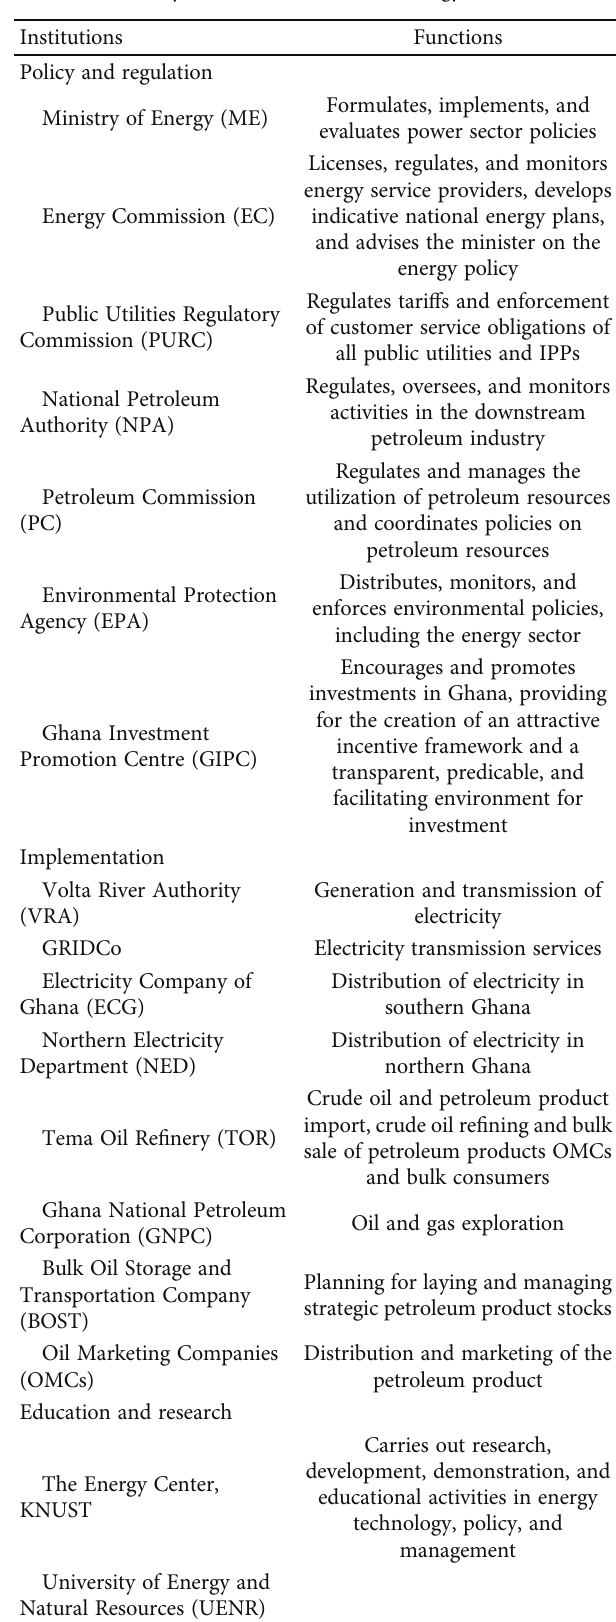
Table 1: Key institutions in Ghana ’ s energy sector